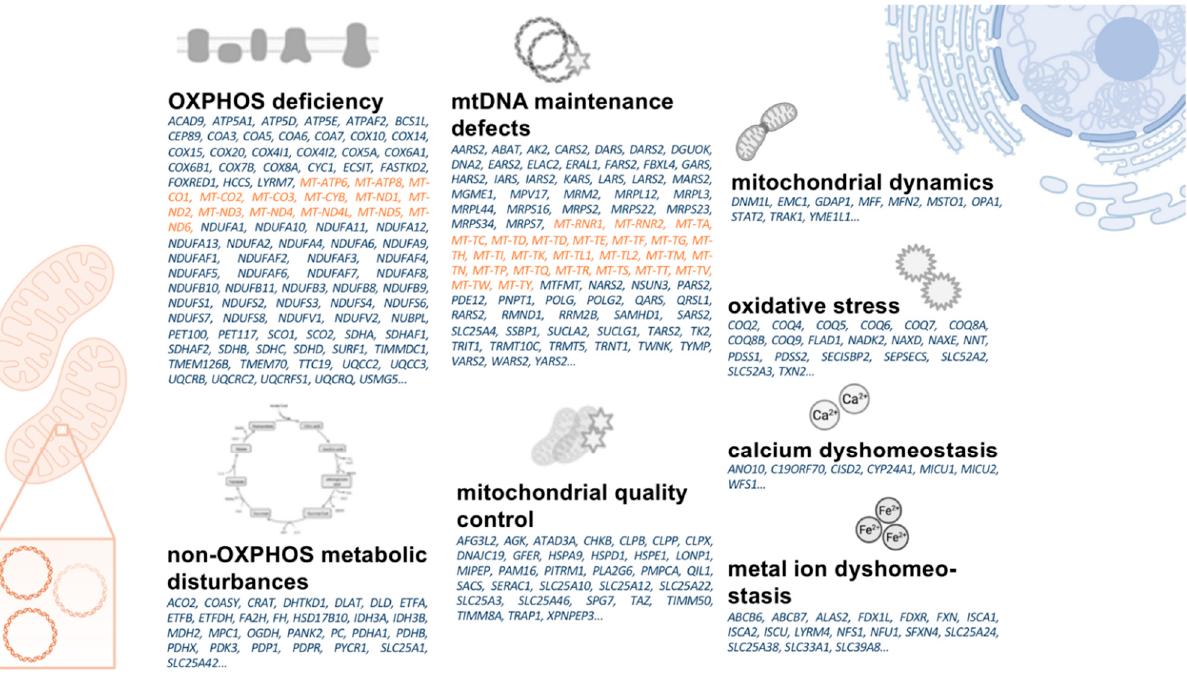
Figure 3. Overview on mtDNA- (orange) and nDNA- (blue) encoded genes causative for primary mitochondrial disorders. The listed genes are ordered based on pathophysiological concepts their respective disorders share with aspects of mito- chondrial dysfunction in PD. mtDNA: mitochondrial DNA. nDNA: nuclear DNA. OXPHOS: oxidative phosphorylation. PD: Parkinson’s disease.